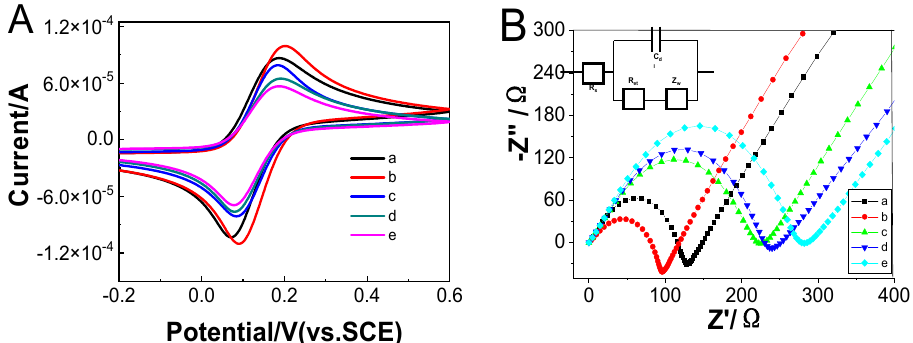
Figure 4. ( A ) CVs and ( B ) nyquist plots of bare (a) SPCEs, GO (b), Apt/GO (c), exosome/Apt/GO (d), cubic AuPt DNs-Ti 3 C 2 -Apt/exosome/Apt/GO (e) modified SPCEs in 0.10 M KCl containing 5.0 × 10 − 3 M K 3 [Fe(CN) 6 ]/K 4 [Fe(CN) 6